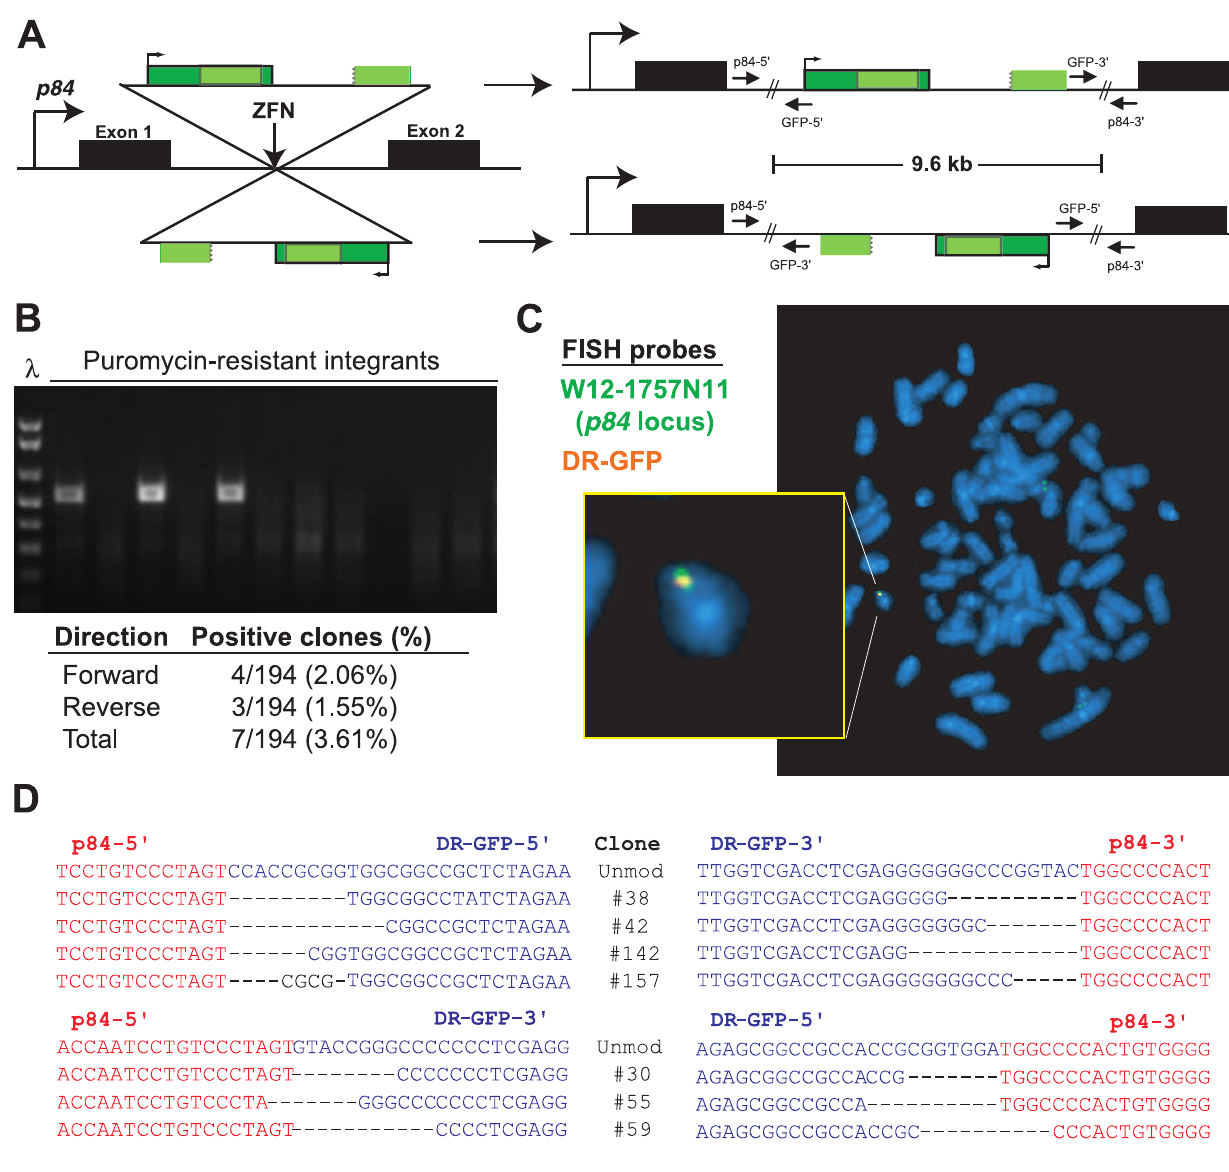
Figure 2. Site-specific targeting without sequence homology. A . DR-GFP can be integrated at the p84 locus in either orientation. B . PCR with p84-5 9 and GFP-3 9 primers demonstrates three 293T clones with site-specific integration. l indicated DNA ladder. C . FISH demonstrates colocalization of probes against DR-GFP (green) and spanning the p84 locus (orange) in 293T cells. D . Sequences at 5 9 and 3 9 borders of integrated DR-GFP. Red sequence is from the p84 locus and blue sequence is from the DR-GFP construct. Integration with no sequence modification is indicated as